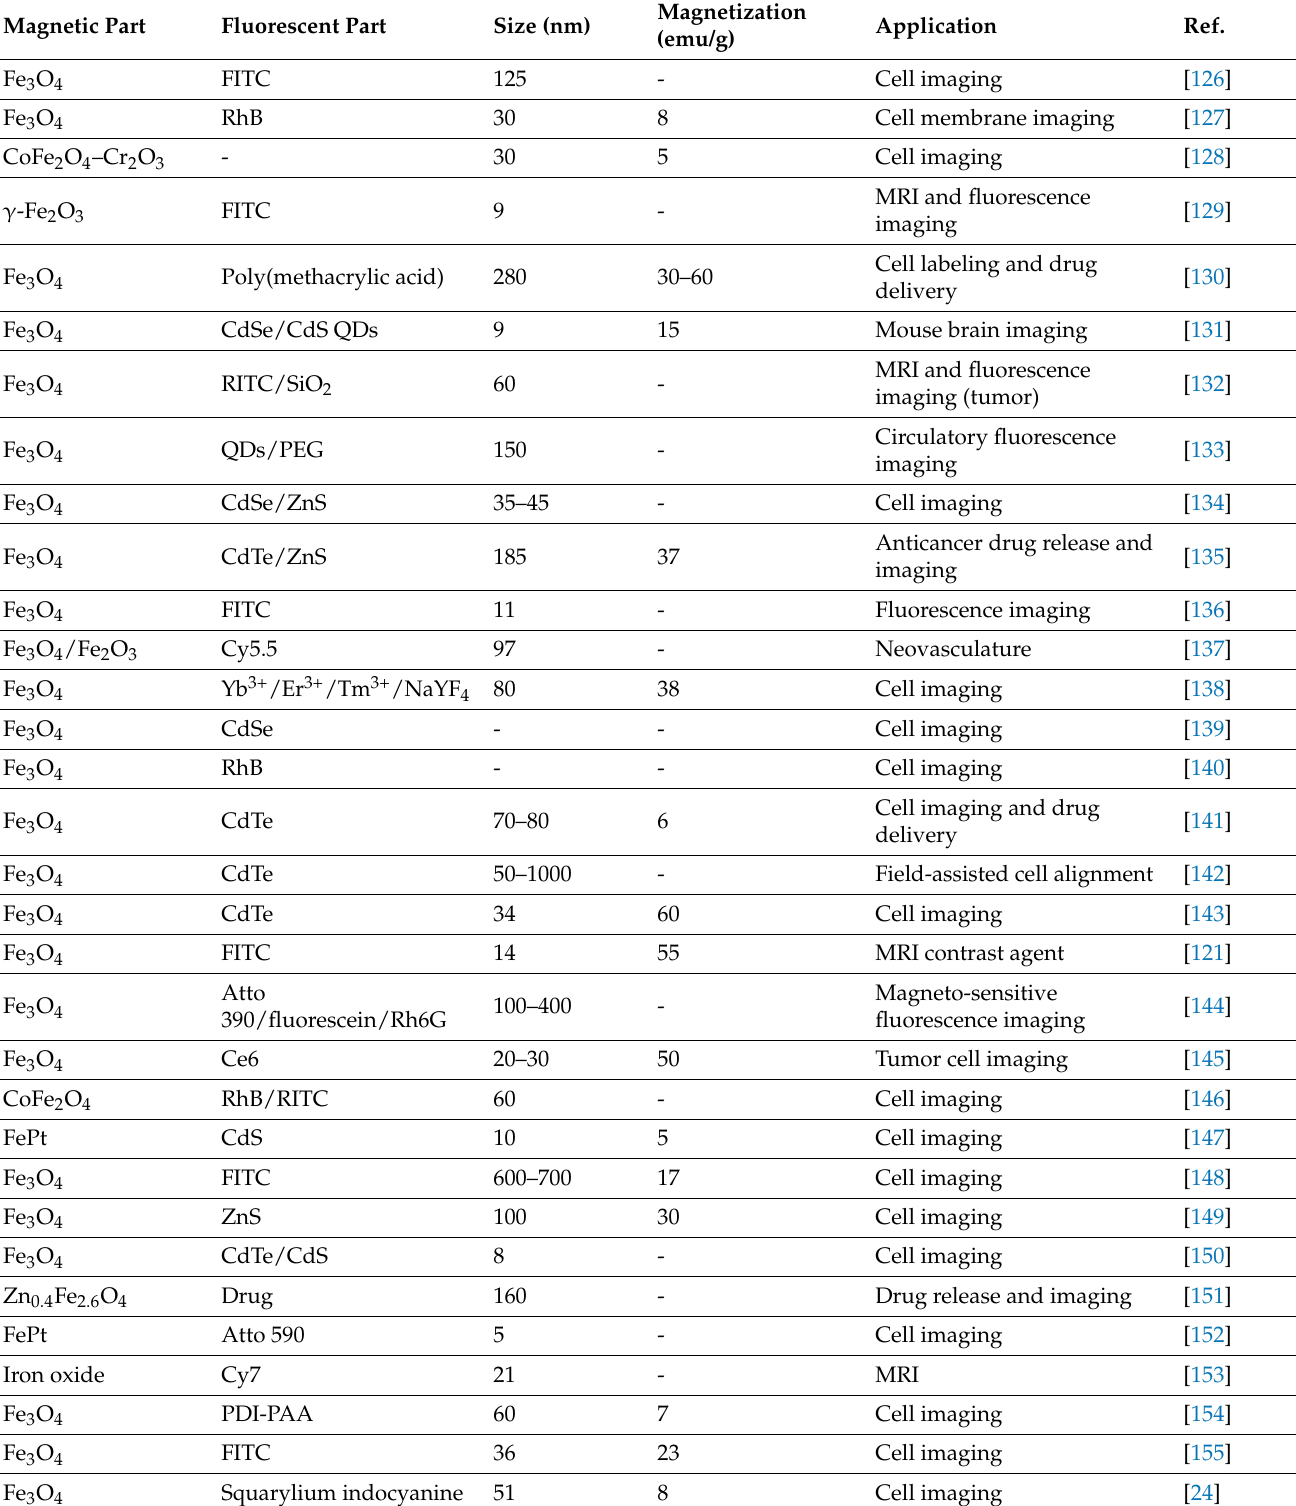
Table 2. Different types of magneto-fluorescent nanoparticles, their magnetic characters, and specific